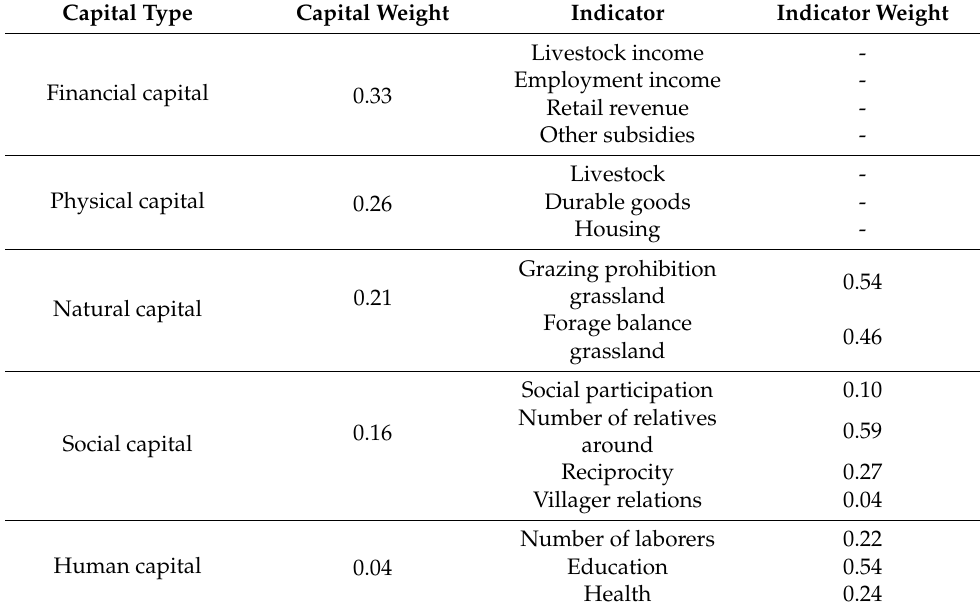
Table 2. Livelihood capital and index weight of